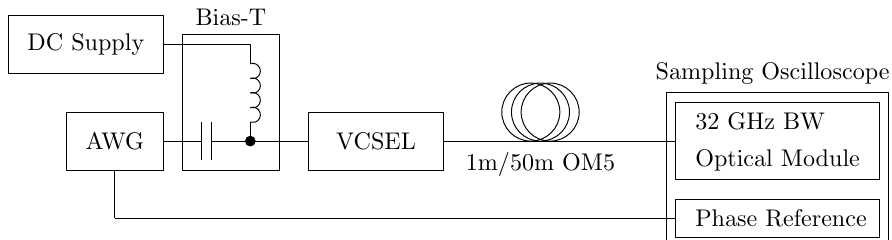
Figure 9. Experimental measurement setup.